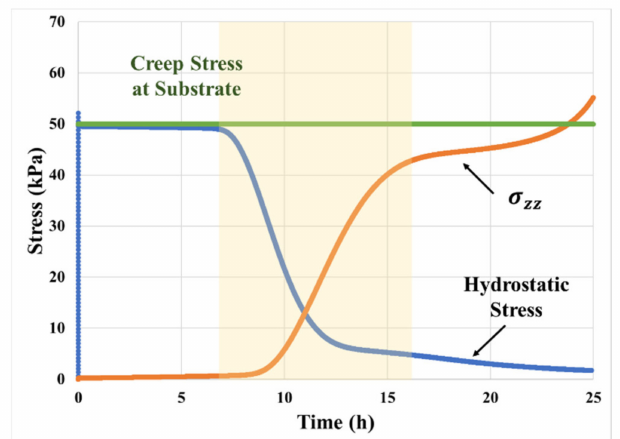
Figure 14. History of deviatoric stress ( z component of the deviatoric part of the viscoelastic stress tensor) and hydrostatic stress in the foot area of PSA